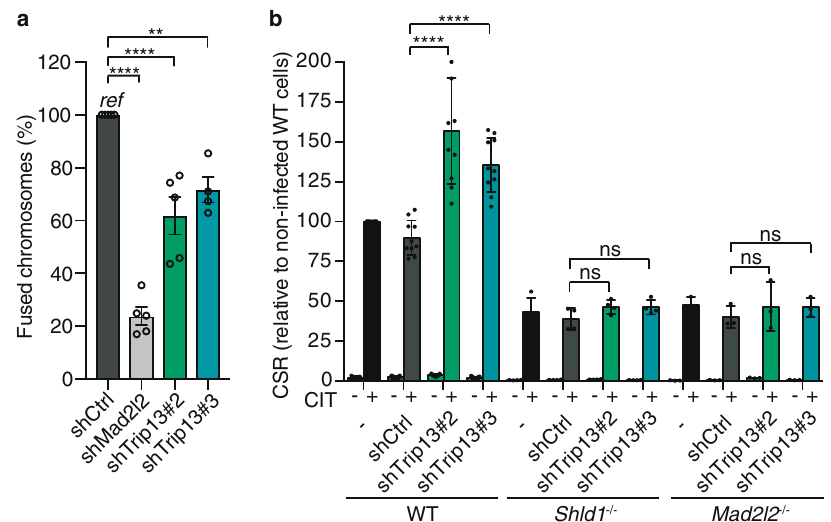
Fig. 5 TRIP13 affects NHEJ-mediated DNA repair. a Chromosome fusions in TRF2ts MEFs infected with indicated shRNAs, after 24 h of telomere uncapping. Values are relative to control infected cells (shCtrl). Dots represent individual experiments ( n = 5, except shTrip13#3 ( n = 4), mean ± s.e.m., >1500 chromosomes counted per condition per experiment), one-way ANOVA, Dunnett ’ s multiple comparisons test (** p = 0.0022; **** p < 0.0001). b CSR is increased in absence of TRIP13, using two different shRNAs, but not in a Shld1- and Mad2l2 -null background. Mean± s.e.m. relative to non-infected WT cells, two-sided Wilcoxon – Mann – Whitney test. n = 10 independent experiments except Shld1 − / − ( n = 4), and Mad2l2 − / − ( n = 3). **** p < 0.0001; ns p = 0.1143 (shCtrl vs. shTrip13#2) and p = 0.3429 (shCtrl vs. shTrip13#3) for Shld1 − / − ; ns p = 1 (shCtrl vs. shTrip13#2) and p = 0.4 (shCtrl vs. shTrip13#3) for Mad2l2 − / − . Signi fi cance; ns, not signi fi cant ( p ≥ 0.05), * *p < 0.01, **** p < 0.0001. Source data are provided as a Source Data fi